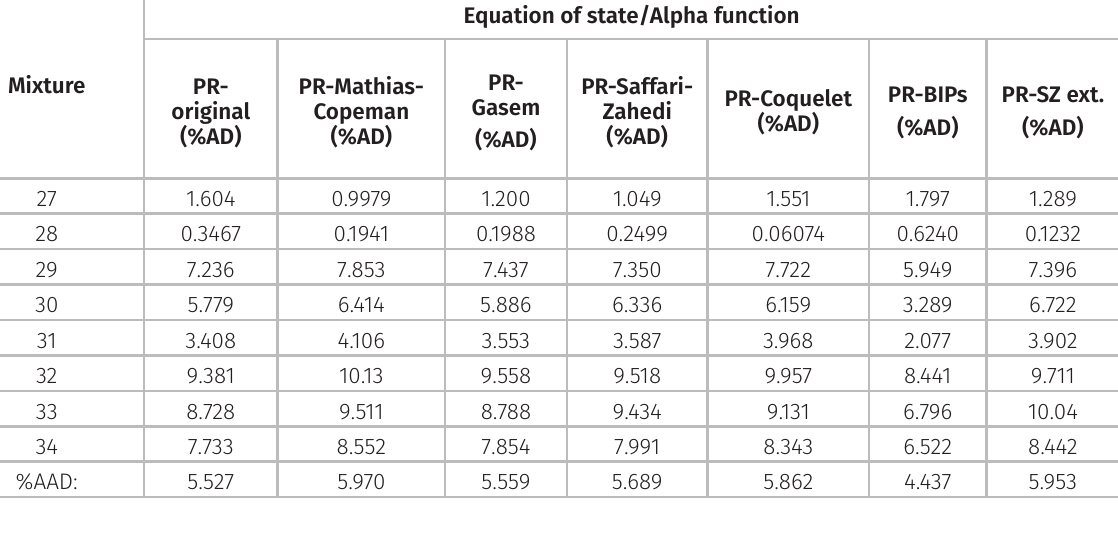
Figure 4. P VT-based and calculated values for the Peng-Robinson (PR), Safarri-Zahedi (SZ) and extended (SZext.) alpha functions (a) and its derivatives with temperature (b) for different